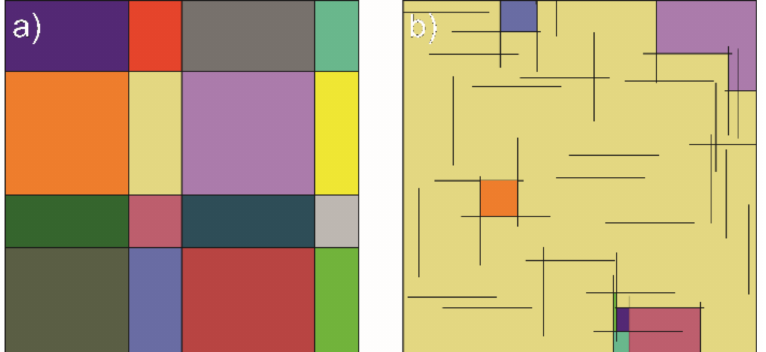
Figure 1. Schematic trace maps illustrating the difference between ( a ) persistent fractures and ( b ) non-persistent fractures (black lines), and their impact on the resulting block areas/sizes (colored areas). Both trace maps are simulated by assuming the same mean 1-D fracture